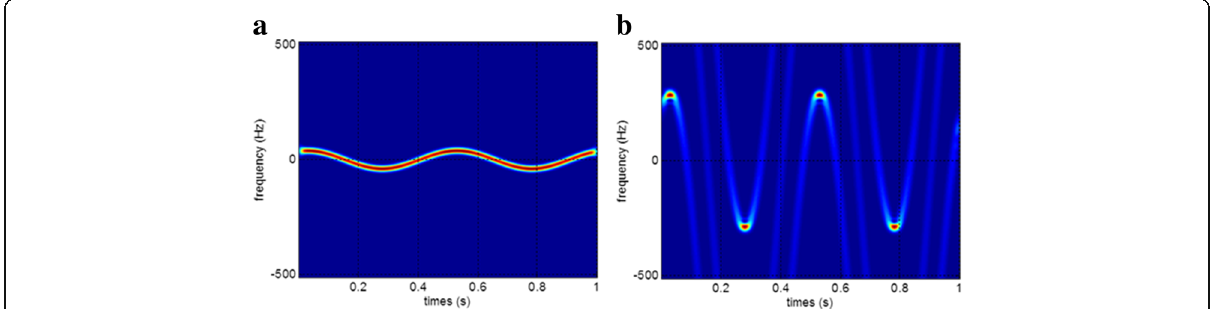
Fig. 2 Time-frequency distributions of a micro-motion scattering center. a The non-aliasing situation at 10 GHz. b The aliasing situation at 0.33